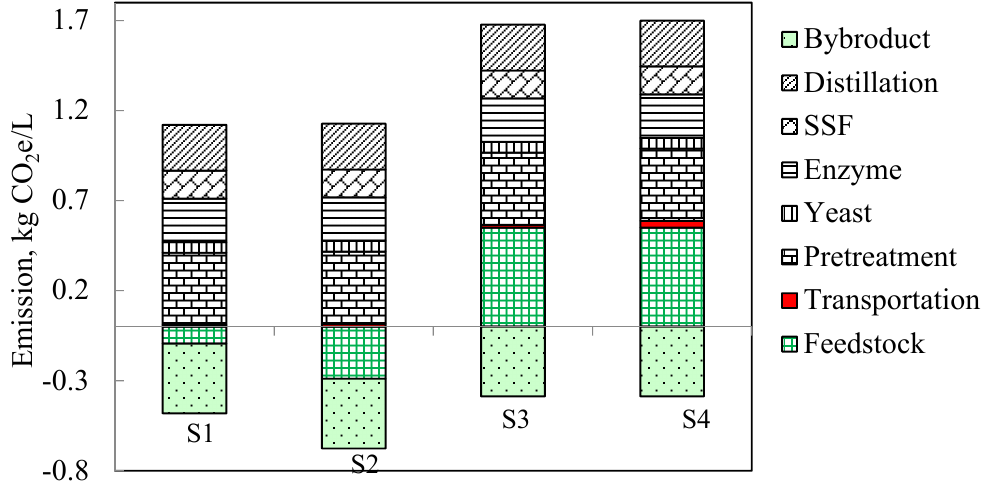
Figure 4. Emission breakdown of the LC of ethanol (Southern